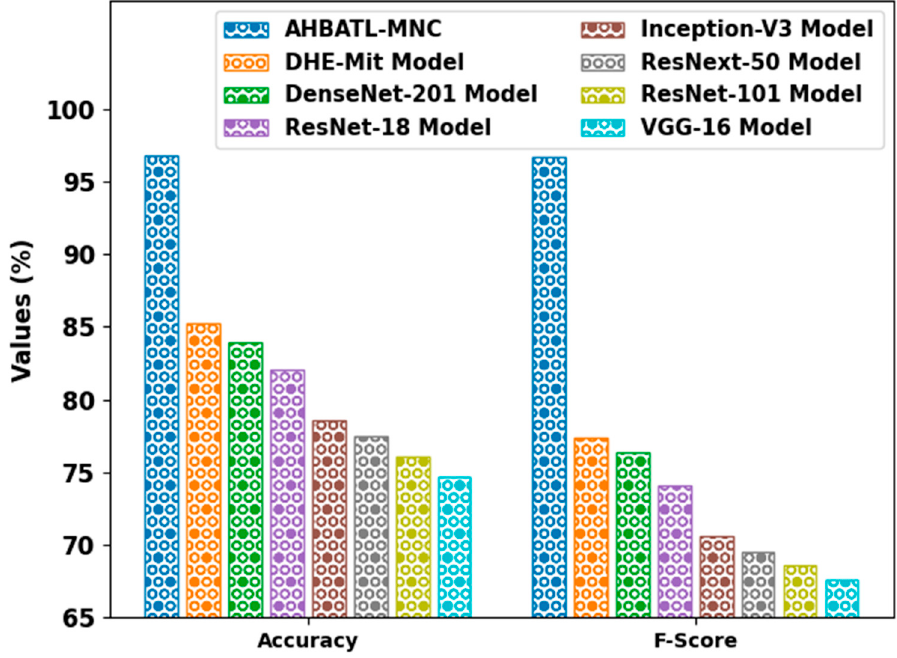
Figure 10. Accu y and F score analysis of AHBATL-MNC system compared with other approaches. Figure 11 provides a comparative examination of the AHBATL-MNC approach with respect to prec n and reca l . The outcomes state that the AHBATL-MNC approach gained enhanced performance. For example, in terms of prec n , the AHBATL-MNC model obtained higher prec n of 96.77%. In contrast, the DHE-Mit, DenseNet-201, and ResNet-18 models attained lower prec n of 84.45%, 83.20%, and 81.26%, correspondingly. Finally, with respect to reca l , the AHBATL-MNC model gained enhanced reca l of 96.77%. In contrast, the DHE-Mit, DenseNet-201, and ResNet-18 methods accomplished lower reca l of 75.26%, 73.85%, and 71.73%, respectively.